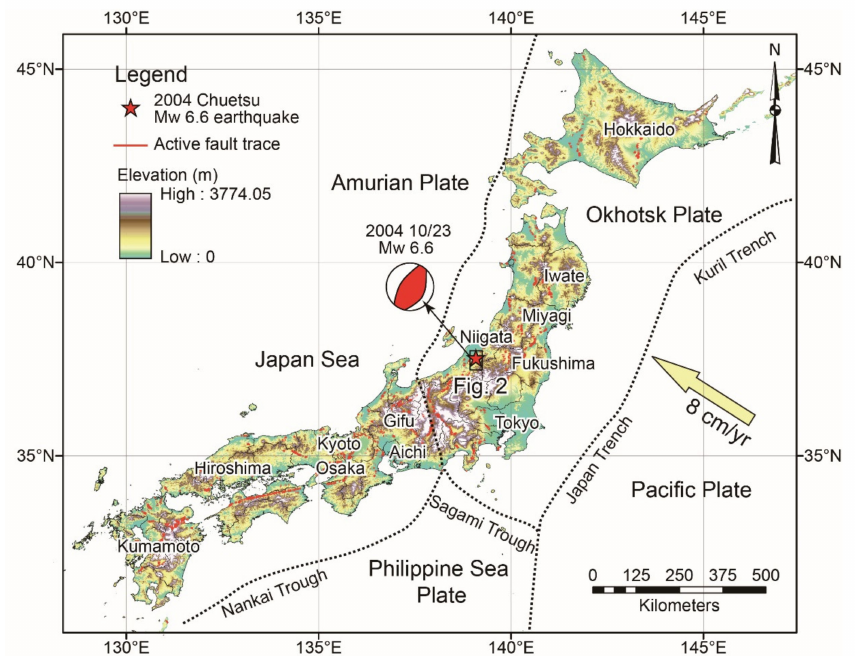
Figure 1. Plate tectonic framework and active faults in Japan. Active fault traces are from [38,39]. The focal mechanism of the 2004 Mw 6.6 The Chuetsu earthquake is from the Harvard centroid moment tensor (CMT) catalogue (http://www.globalcmt.org/CMTsearch.html (accessed on 1 December 2020)). The red star indicates the epicentre of the 2004 Chuetsu earthquake. The black rectangle shows the detailed location of Figure